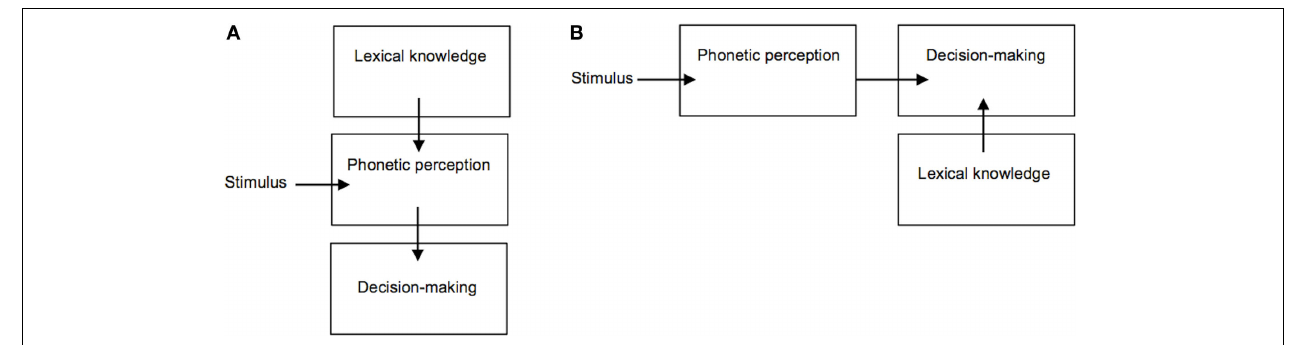
FIGURE 2 | Competing accounts of the lexical effect on phoneme perception. (A) Lexical knowledge directly influences phonetic perception; (B) Lexical knowledge is used at a later stage for the purpose of explicit decision-making.